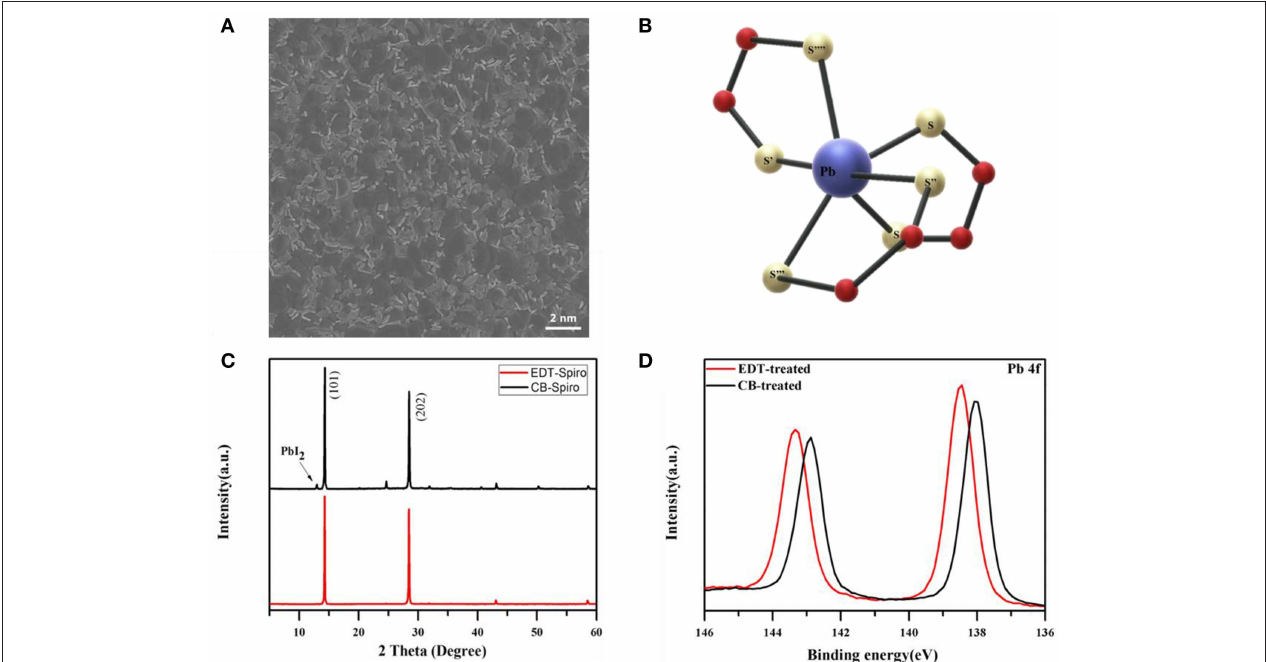
FIGURE 1 | (A) SEM images of the top view of perovskite films. (B) The model for Pb(II) cooperate with EDT. (C) XRD patterns of perovskite films processed with EDT and CB. (D) XPS spectra of Pb 4f with the CB and EDT solvents processed perovskite